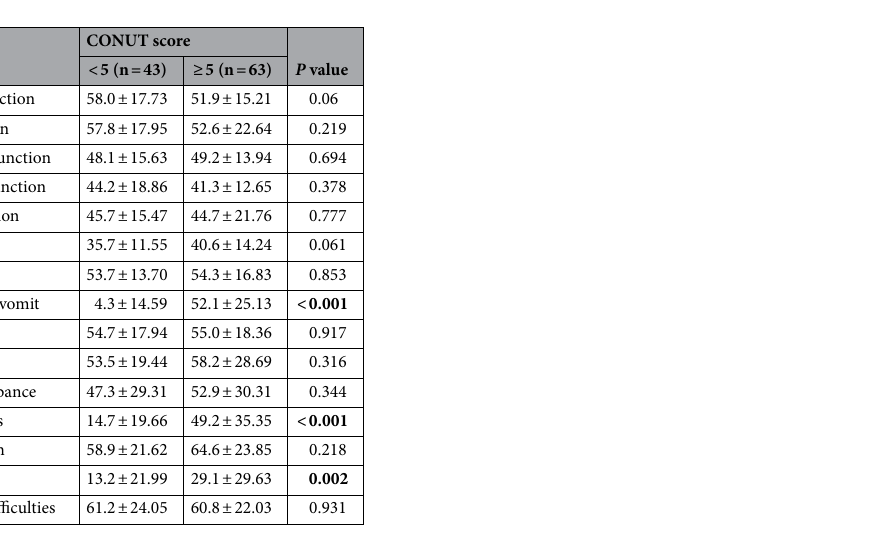
Table 11. The relationship between CONUT and preoperative